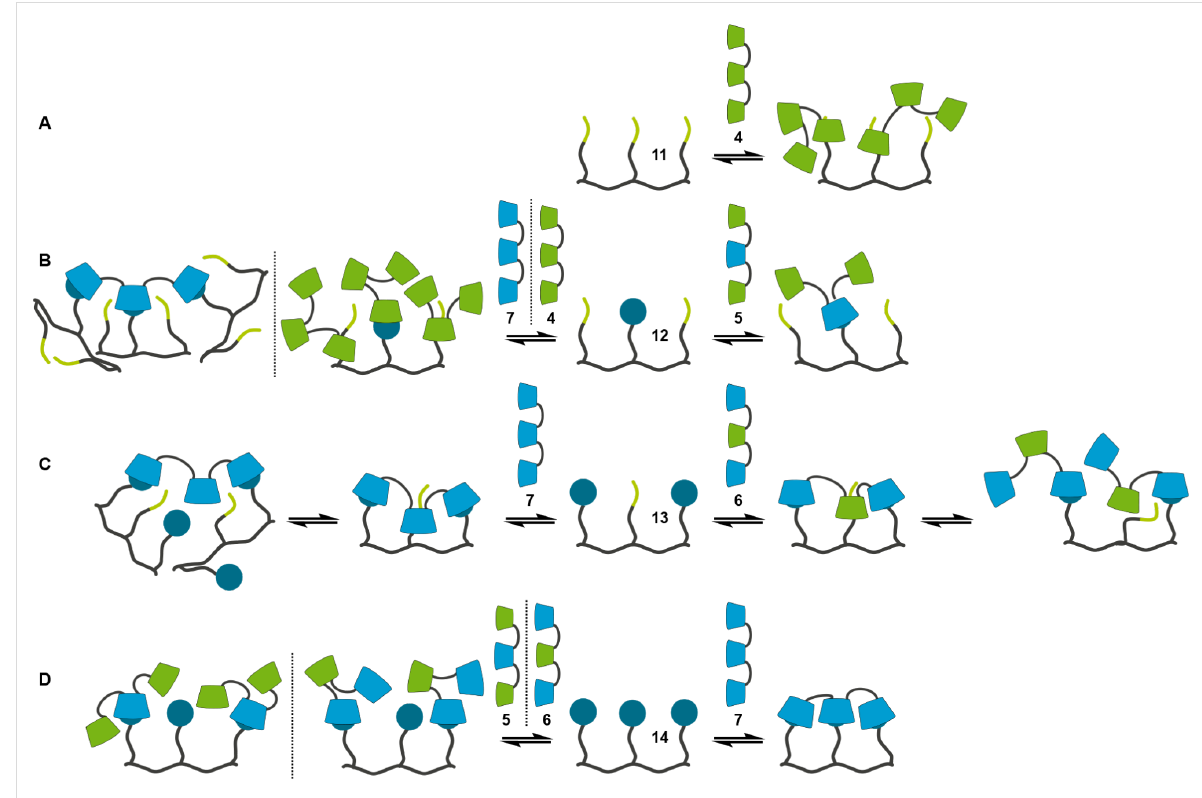
Figure 9: Schematic drawing of the interactions of the trivalent guest molecules 11 (A), 12 (B), 13 (C) and 14 (D) with complementary (right) and non- complementary (left) trivalent CD strands.